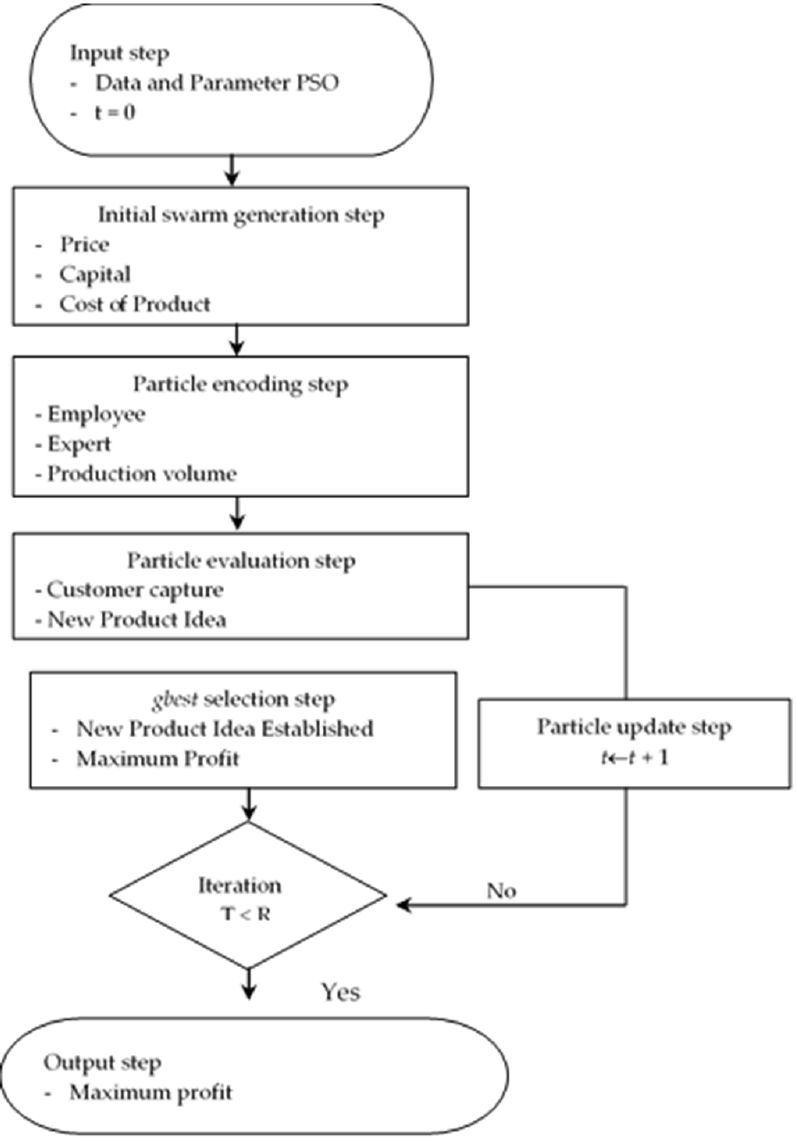
Figure 2. Flowchart for the proposed particle swarm optimization (PSO) algorithm.